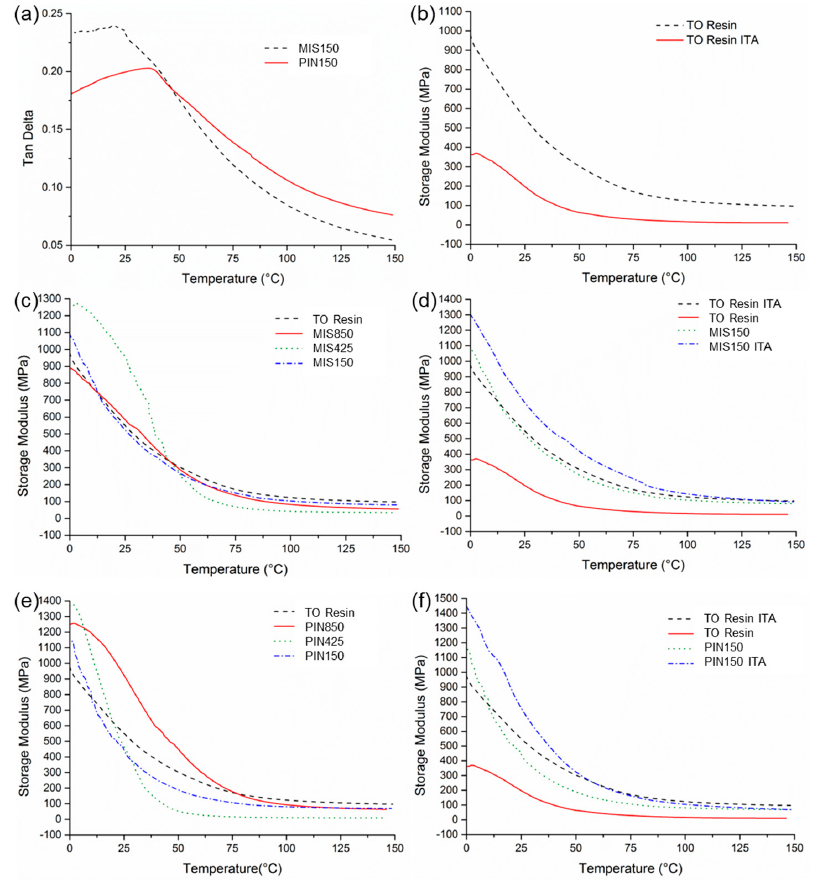
Figure 4. ( a ) Tan Delta vs. temperature curves of composites reinforced with southern pine and miscanthus. Storage modulus vs. temperature curves of ( b ) unreinforced resins, ( c ) silvergrass composites with different particle sizes, ( d ) silvergrass composites with and without ITA, ( e ) southern pine composites with different particle sizes, and ( f ) southern pine composites with and without ITA.